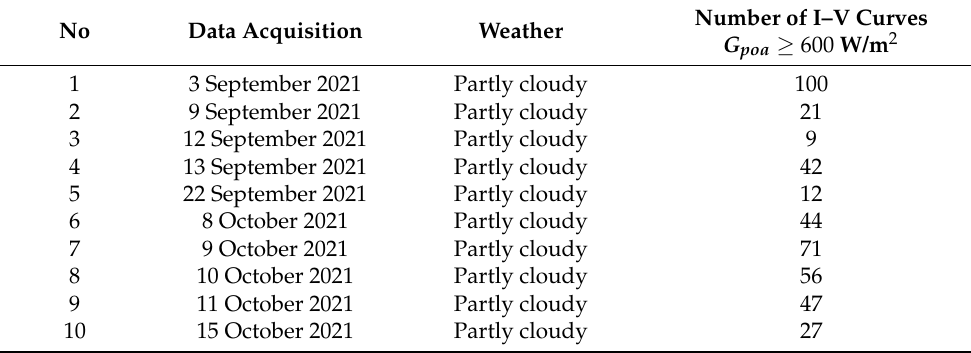
Table 12. Data used for the validation